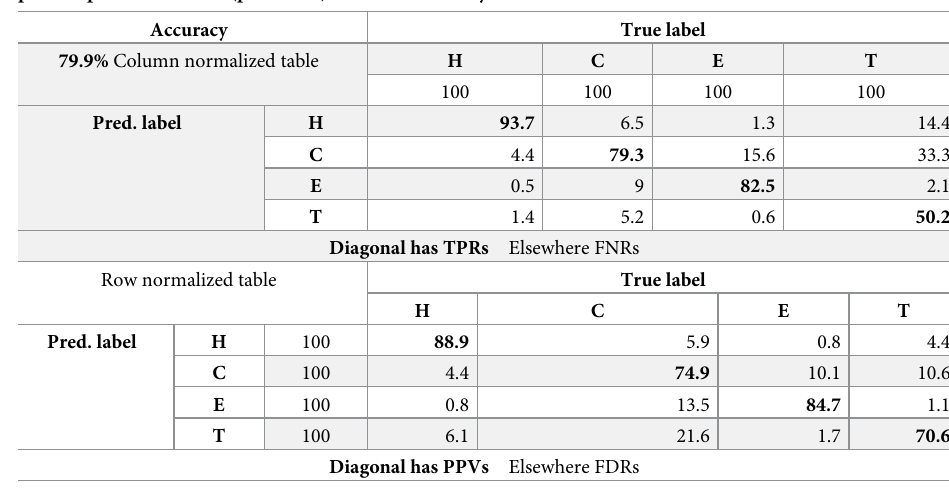
Usage of our secondary-structure prediction software